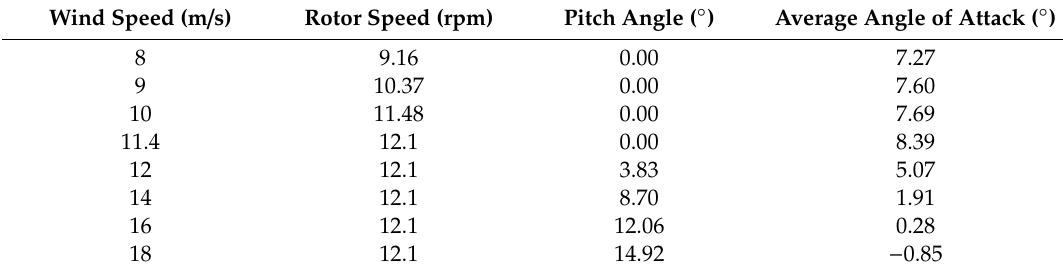
Table 1. Rotor speed, blade pitch angle, and average angle of attack of the profile with the trailing-edge flap at di ff erent wind